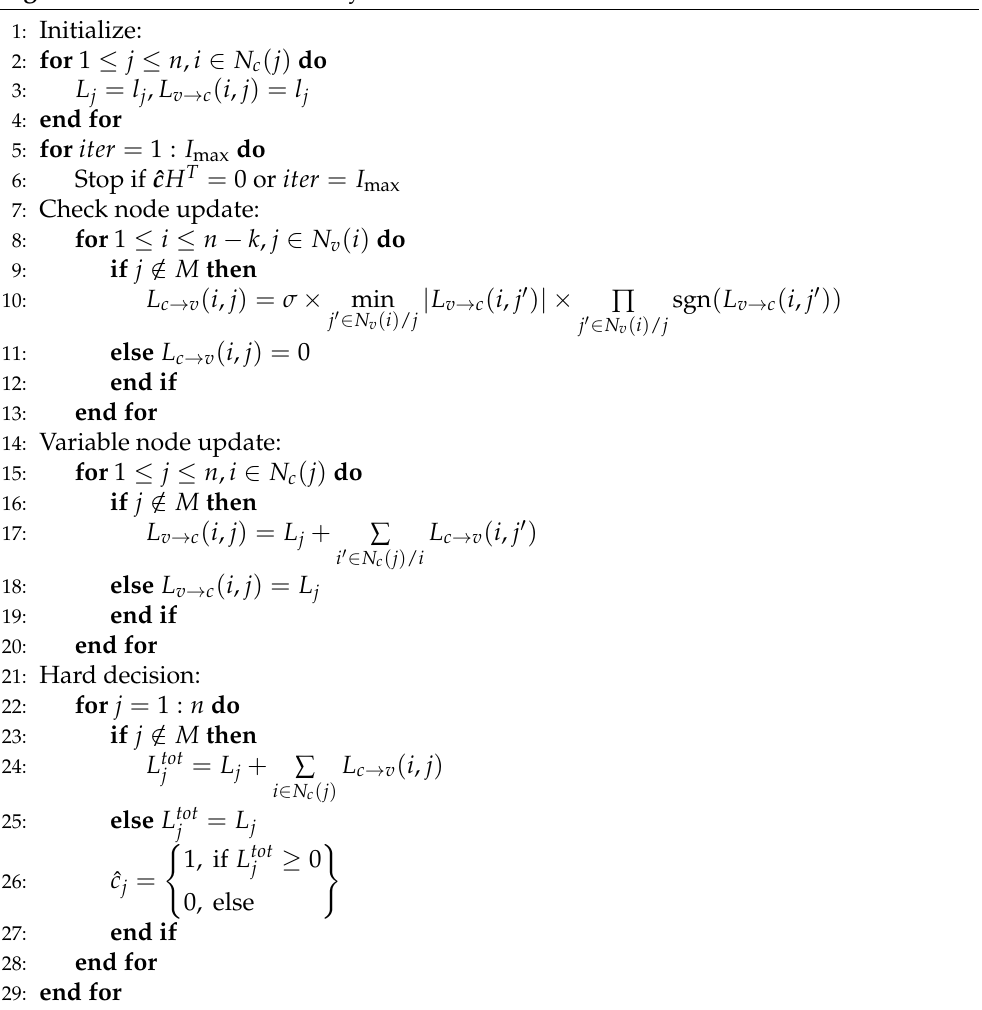
Algorithm 1 INMS for the binary LDPC code